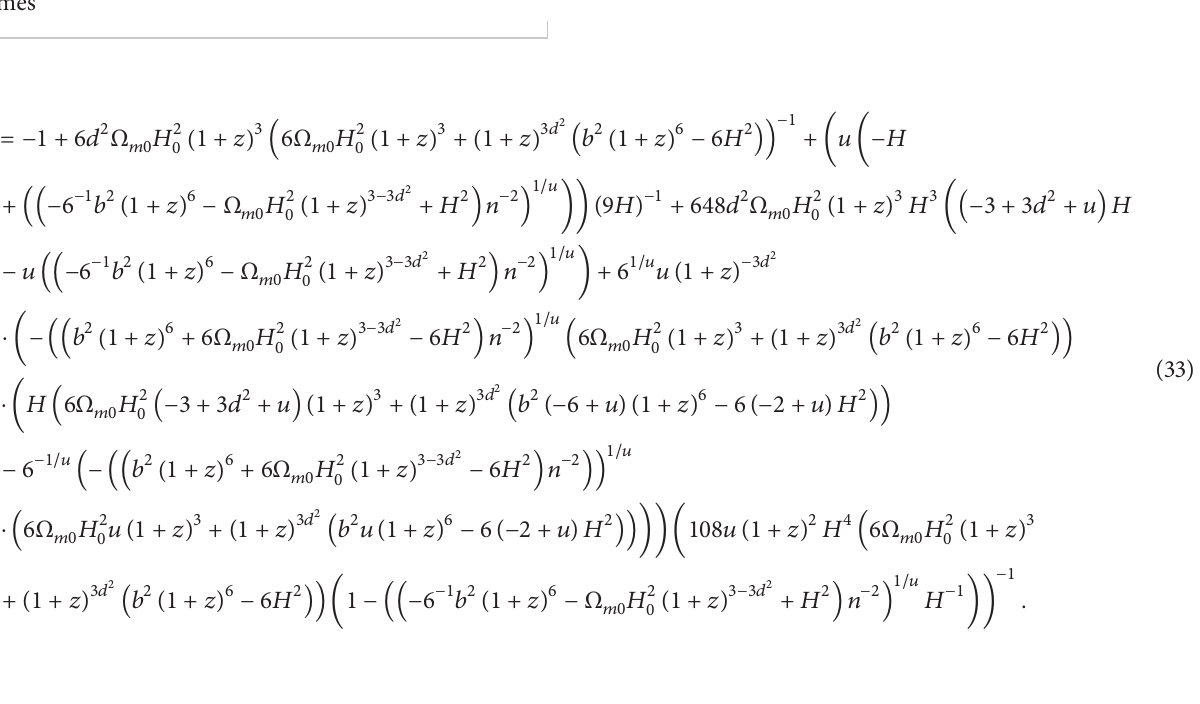
For event horizon PDE, the squared speed of sound